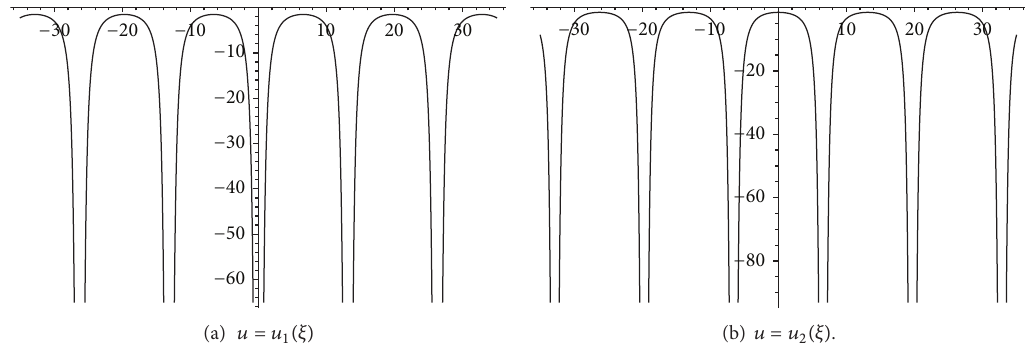
Figure 1: The graphs of 𝑢 1 (𝜉) and 𝑢 2 (𝜉) when 𝛼 = 𝛽 = 𝛾 = 1 , 𝑐 = 2 , and 𝑔 = −2√3/9